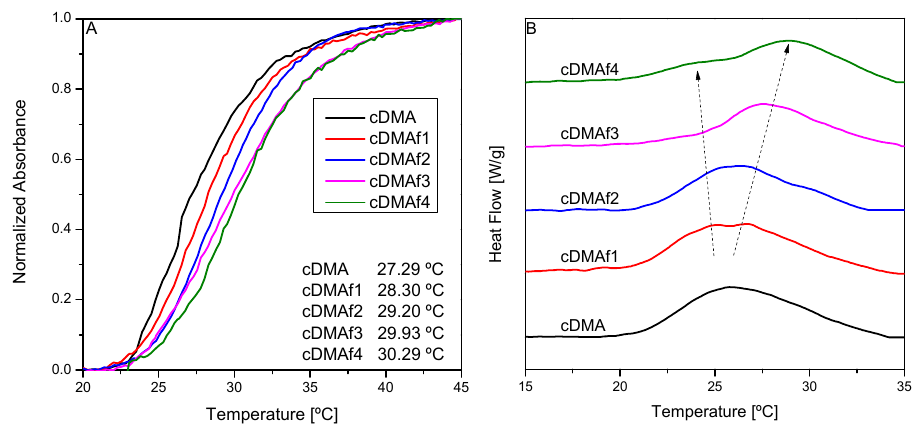
Figure 5. Phase transition temperatures analyzed by UV–vis spectroscopy ( A ) and calorimetry ( B ) for all polymeric solutions (1 wt.%).